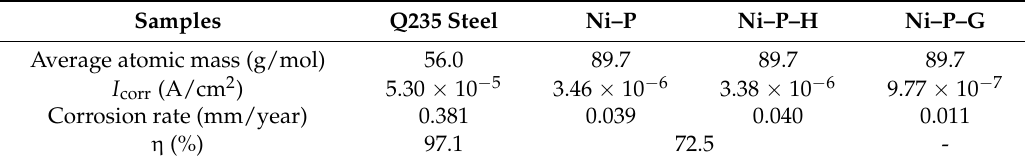
Figure 6. Potentiodynamic polarization curves of the Q235 steel, Ni–P, Ni–P–H, and Ni–P–G in 3.5 wt % NaCl solution. Table 2. Parameters achieved from potentiodynamic curves and calculated corrosion rates of the